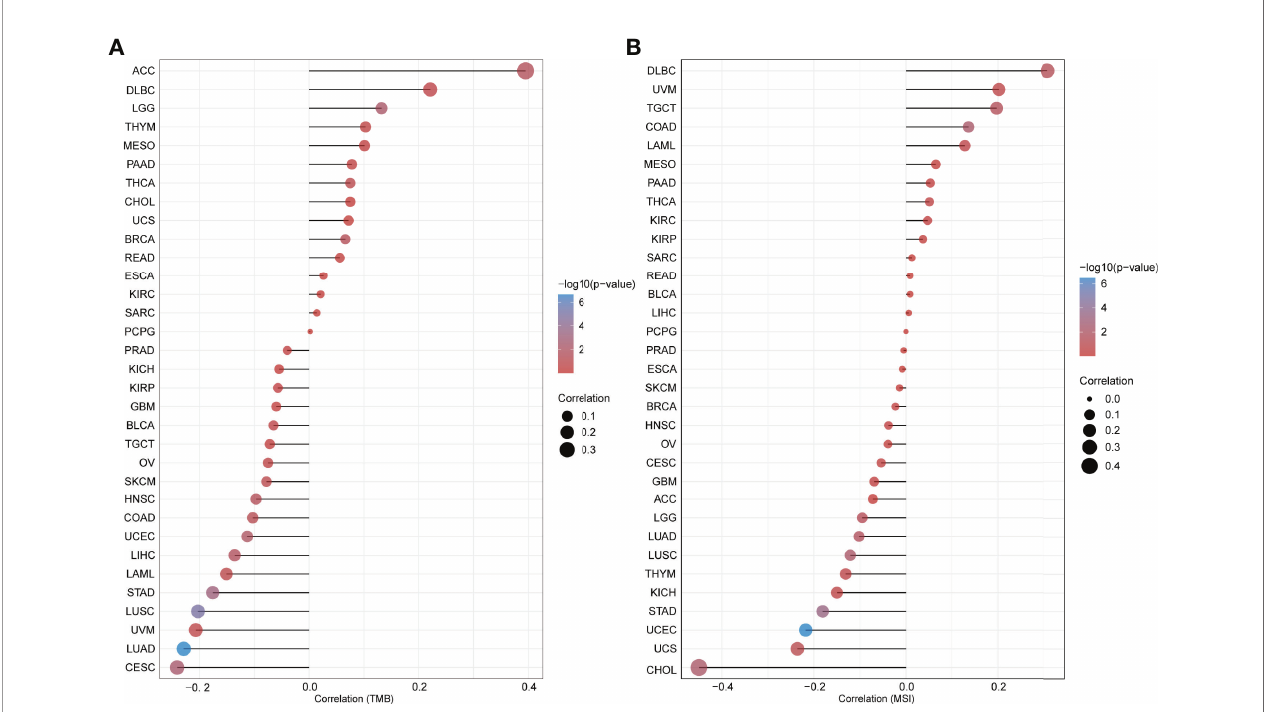
FIGURE 5 | Correlation between the expression of MMP7 and tumor mutational burden (TMB)/microsatellite instability (MSI). Spearman ’ s correlation analysis of the tumor mutational burden (TMB) (A) microsatellite instability (MSI) (B) and MMP7 gene expression. The horizontal axis represents the correlation coef fi cient between MMP7 and TMB/MSI, the ordinate is the different cancer types, the size of the dots represents the size of the correlation coef fi cient, and the different colors represent the signi fi cance of the P